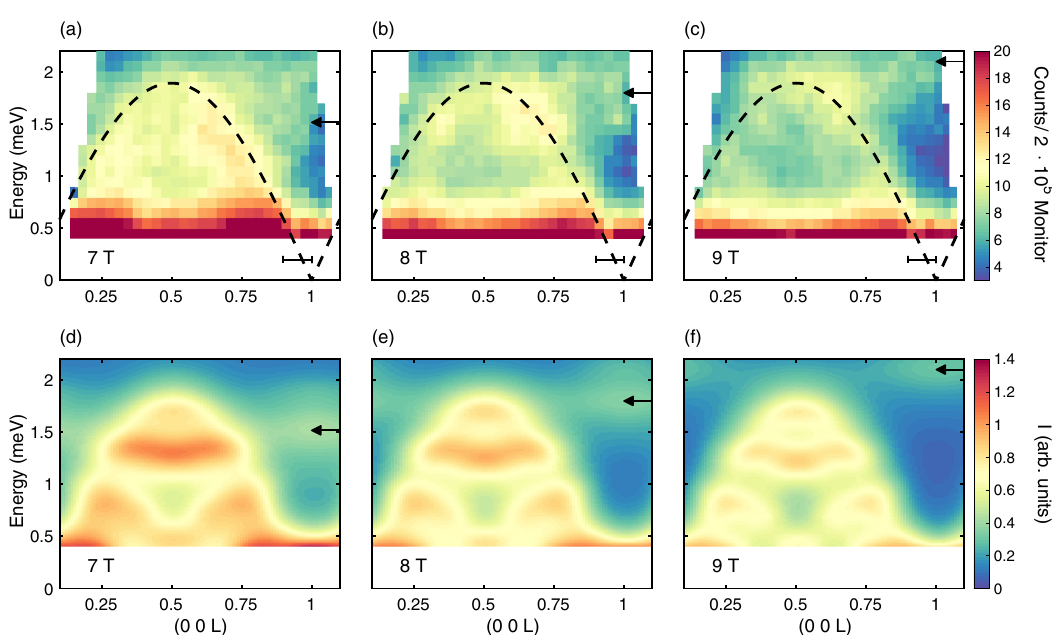
Fig. 4 Inelastic neutron scattering data compared to RPA calculations. a – c Experimental data collected at 22 K at MACS in magnetic fi elds 7 T, 8 T and 9 T, respectively. d – f The calculated inelastic neutron scattering cross section, leaving out the variation due to the magnetic form factor (see Supplementary Note 2), as determined by the six spin-1/2 cluster model 24 . The black arrows correspond to the prediction of the effective Bloch energy, _ ω (cid:5) equation (7). The black bars in a – c represent the data integration range used to produce the data in Fig.